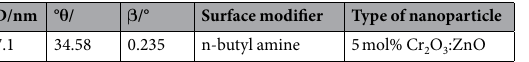
The average percent of removed Aniline (%)